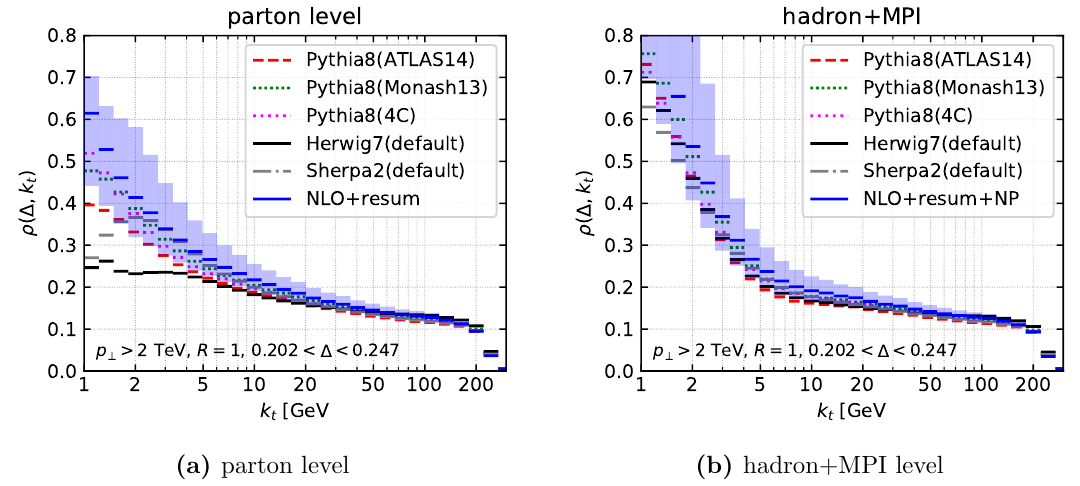
Figure 16. Comparison between our results for (cid:26) and those obtained with the Monte Carlo generators used to estimate non-perturbative